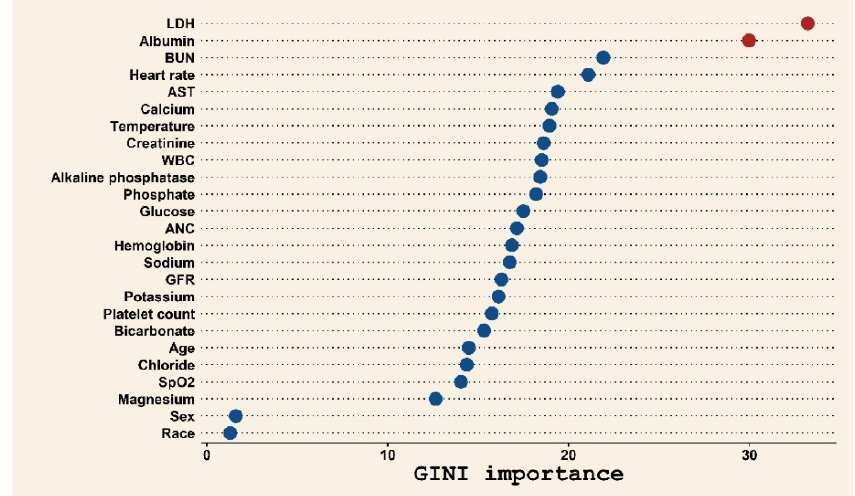
Figure 2. Classification of 14-day mortality using common clinical and laboratory variables among cancer patients presenting to the emergency department with suspected infection. Abbreviations: LDH, lactate dehydrogenase; BUN, blood urea nitrogen; AST, aspartate aminotransferase; WBC, white blood cell count; ANC, absolute neutrophil count; GFR, glomerular filtration rate; SpO2, oxygen saturation.